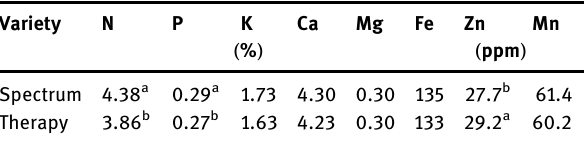
Mean values with the same lower - case letter within the same column are not signi fi cantly di ff erent at the 0.05 probability level.